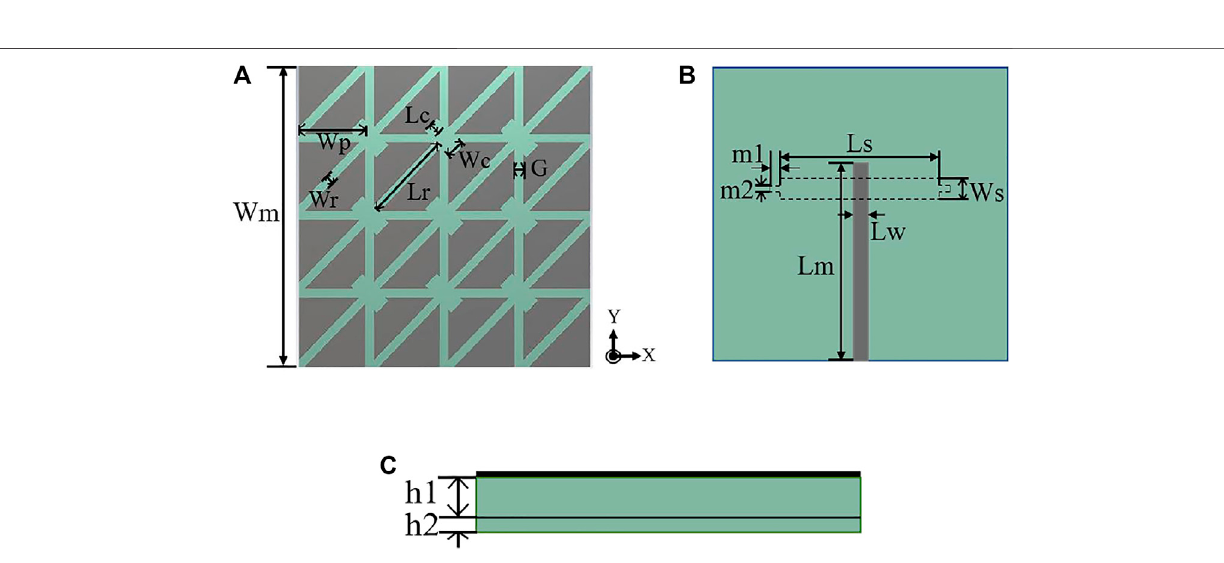
Frontiers in Physics | www.frontiersin.org February 2022 | Volume 10 | Article 860606